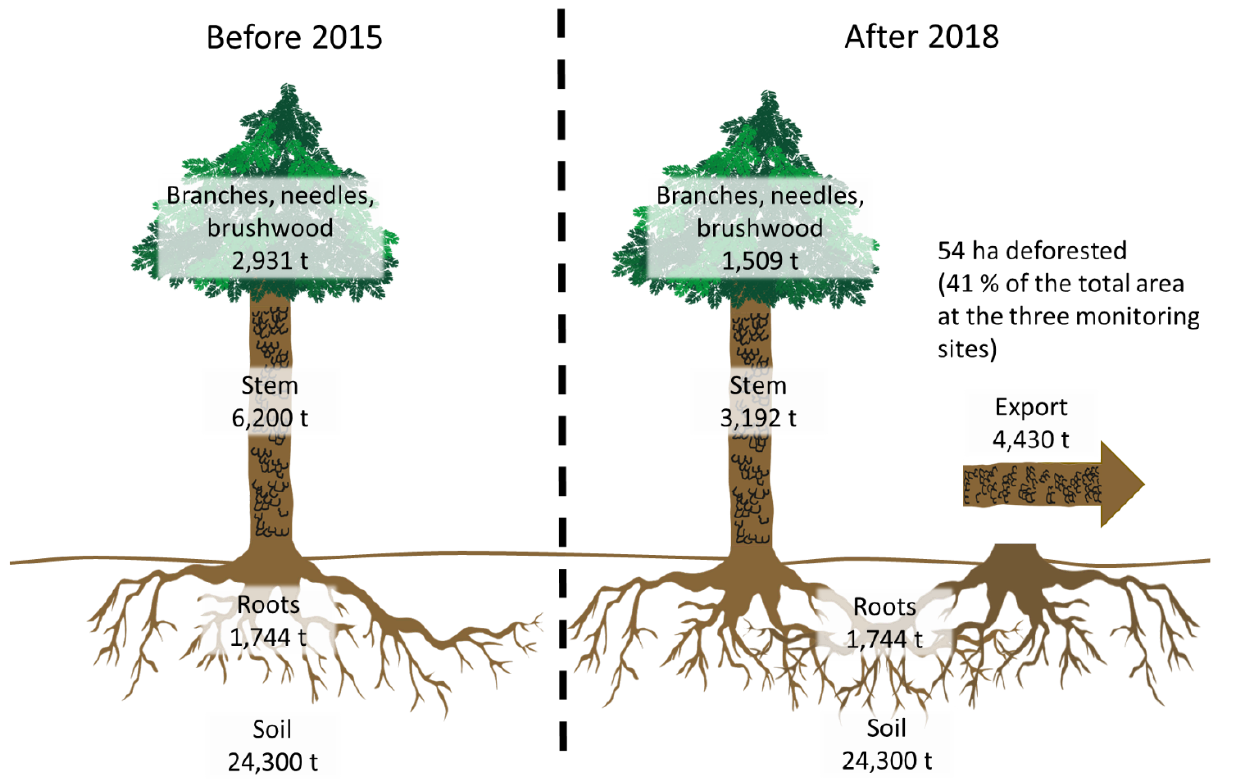
Figure 8. Total carbon stocks from monitoring sites of peatland forests before (left) and after the tree removal